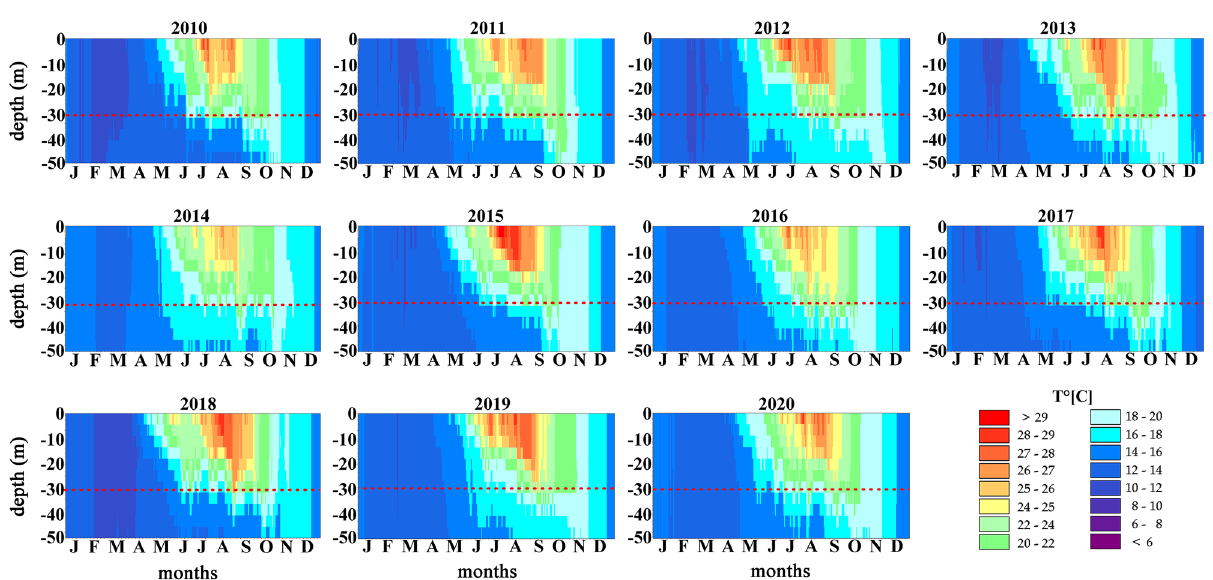
Figure 7. Vertical profiles of water temperature from surface to 50 m depth, from 2010 to 2020, in the Central Adriatic Sea (daily averages from MEDSEA analysis). The dashed red line marks the bathymetry of 30